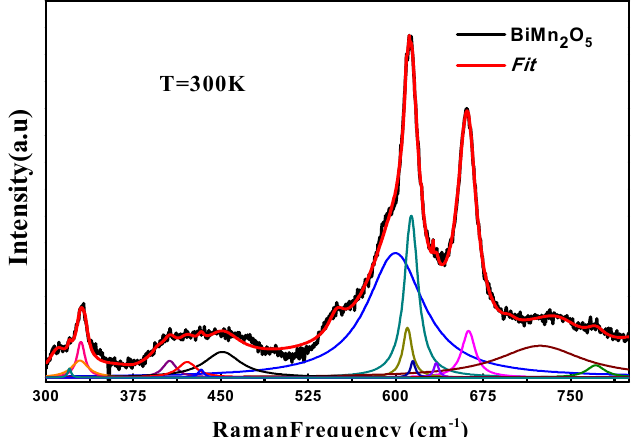
Figure 5. Deconvolution of the Raman spectrum of our sample for T = 300 K.